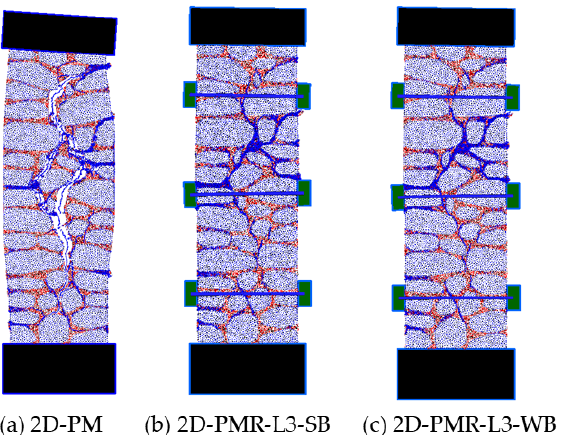
Figure 9. Numerical models: contact damage distribution ( a ) without and ( b , c ) with reinforcement (strong and weak